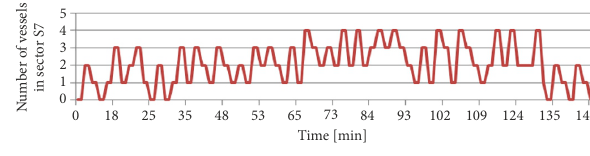
Figure 6. Number of crossing vessels in sector S6